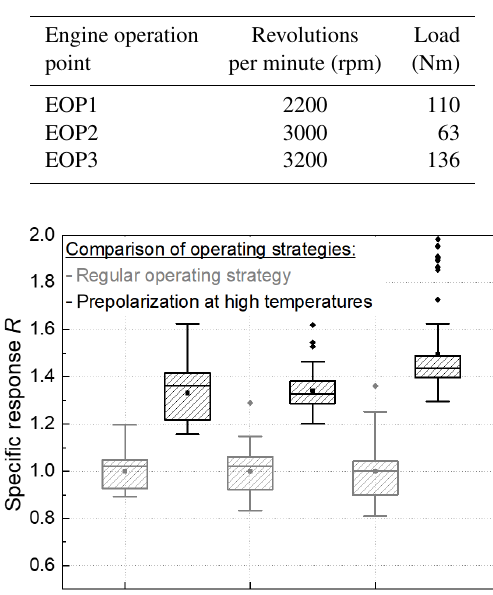
Table 1. Definition of the engine operating points (EOPs). The ex- periment was carried out at the BMW N47 test bench.